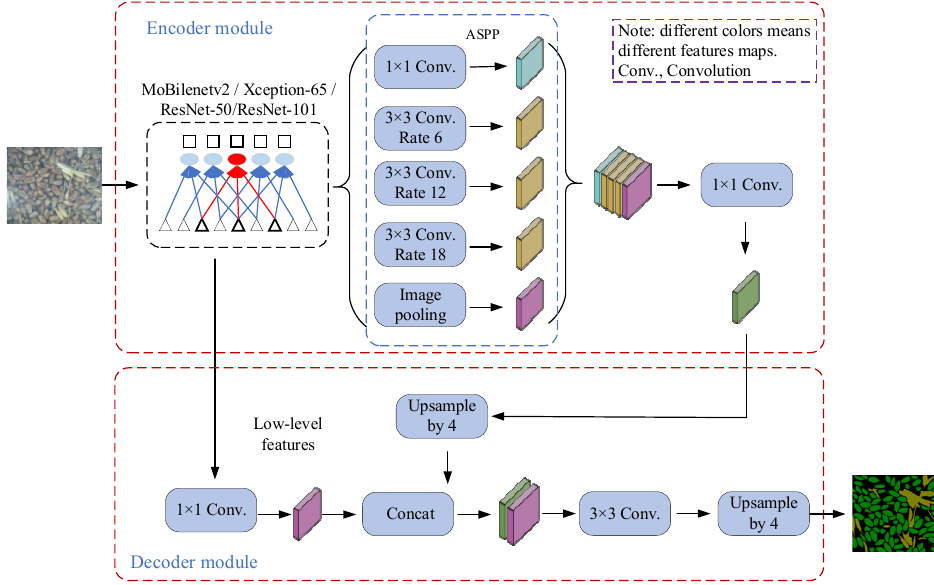
Figure 2. Block diagram of the action of DeepLabV3+ on mechanized harvested wheat